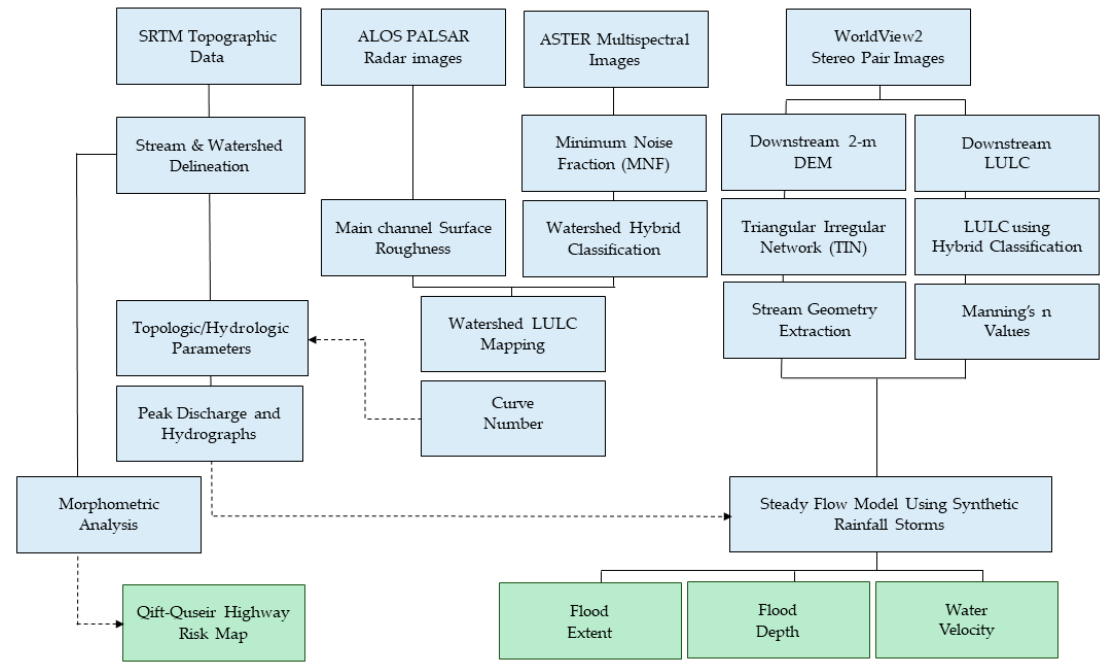
Figure 2. Simplified workflow for the used data and adopted methodology.